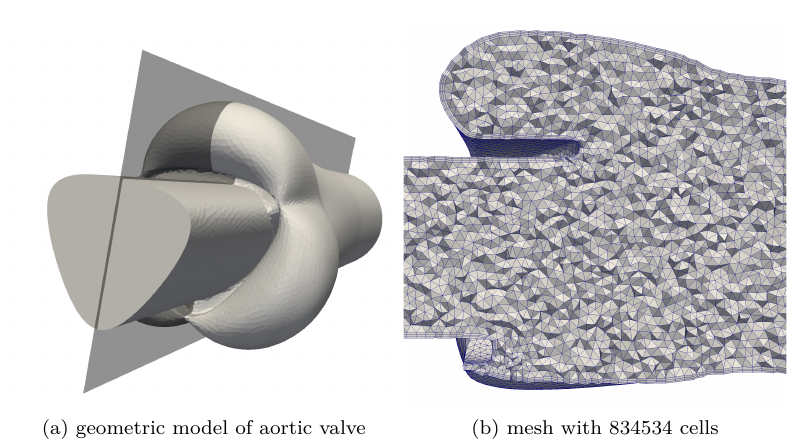
Figure 1. Problem geometry of open and fixed aortic valve and computational